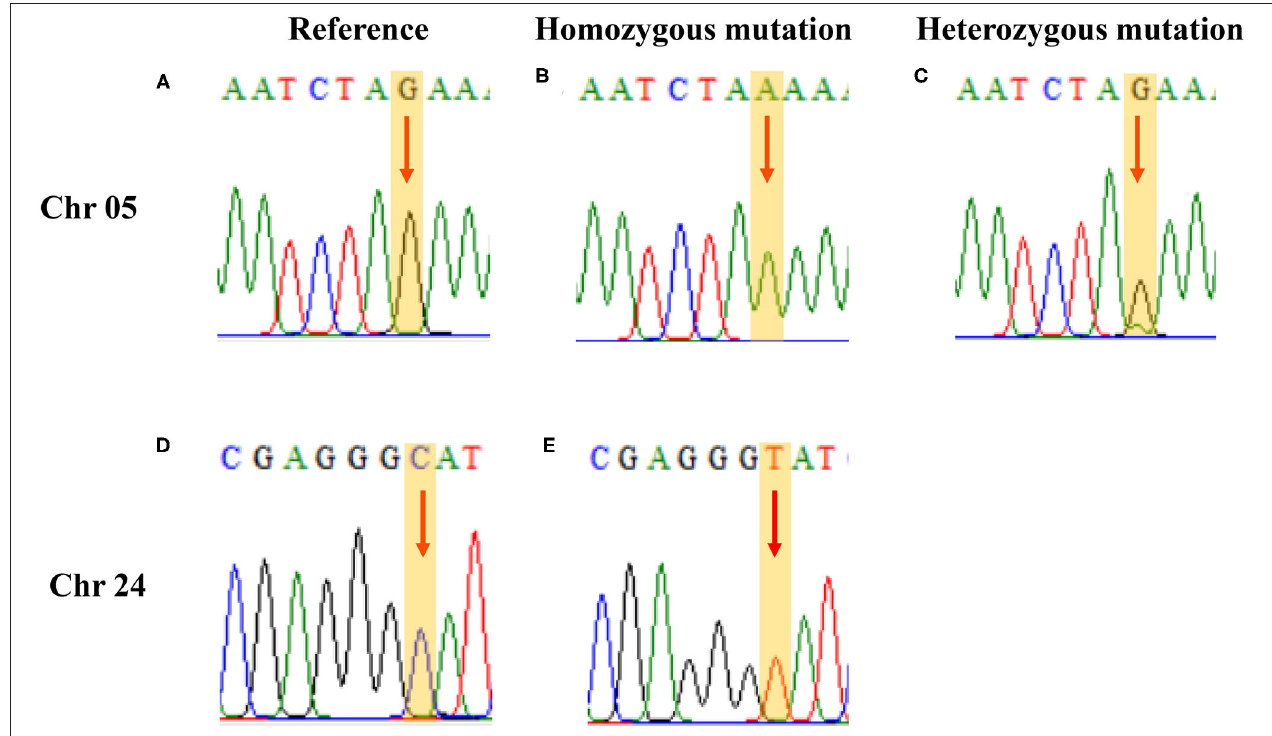
FIGURE 6 | PCR verification results. (A, D) the same as the reference; (B, E) homozygous mutation; and (C) heterozygous